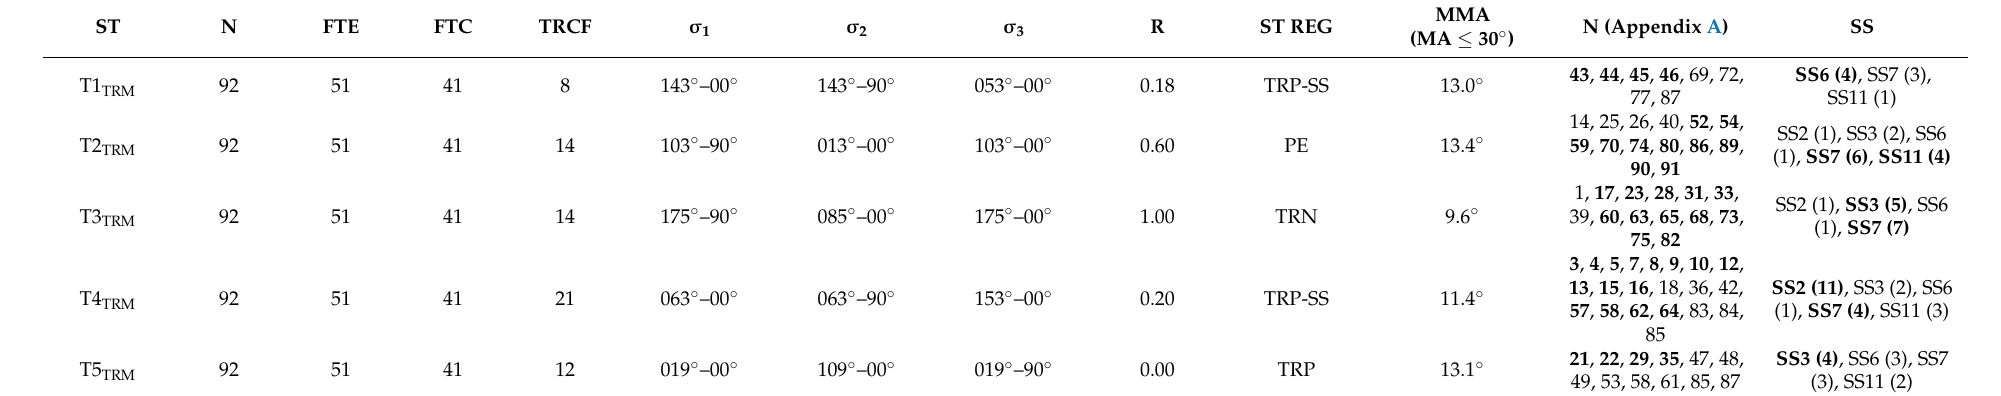
Table 3. The enhanced Andersonian bulk stress tensors with the TRM application [41].